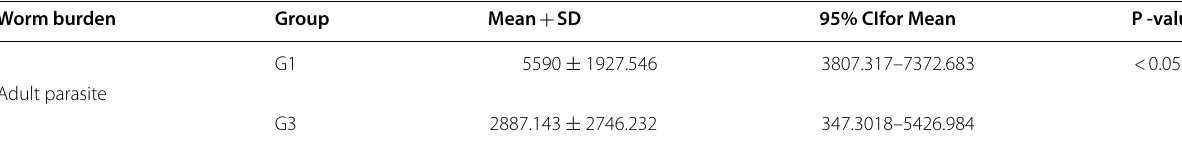
Table 2 Mean worm burden, goats and sheep experimentally infected with H. contortus Worm